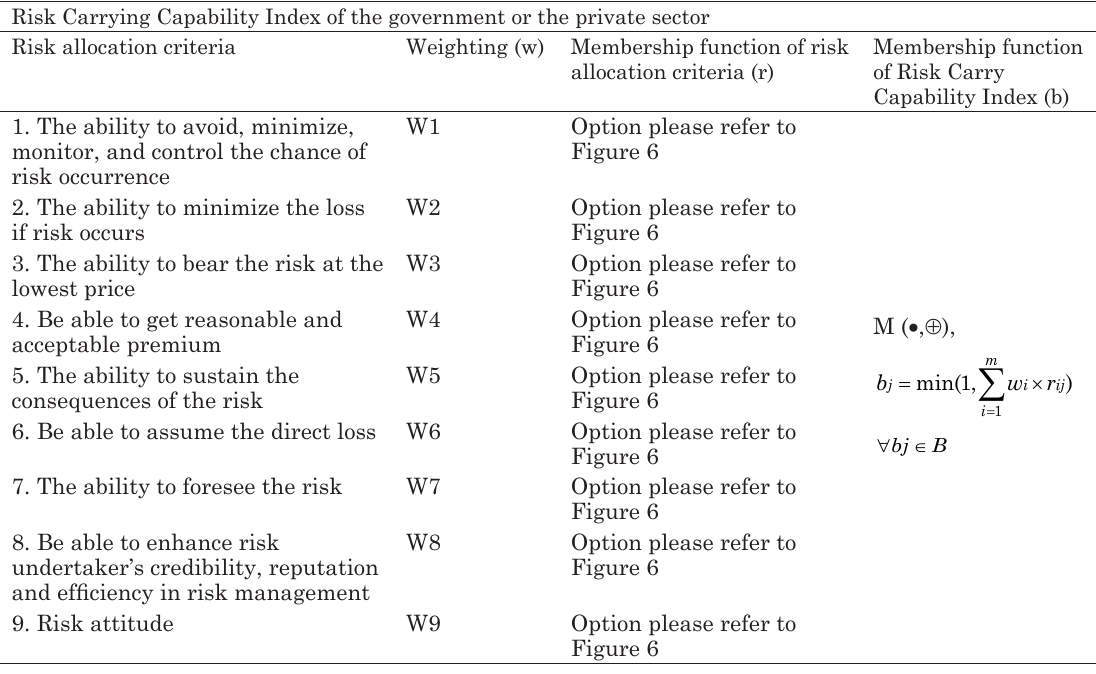
table 5. Calculation of risk Carrying Capability Index risk Carrying Capability Index of the government or the private sector risk allocation criteria